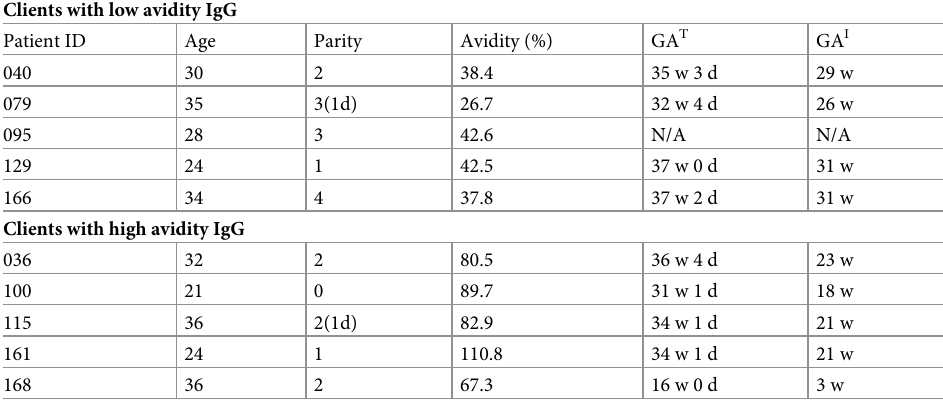
Table 6. Estimation of time of infection of pregnant women with rubella virus immunoglobulin M (IgM).